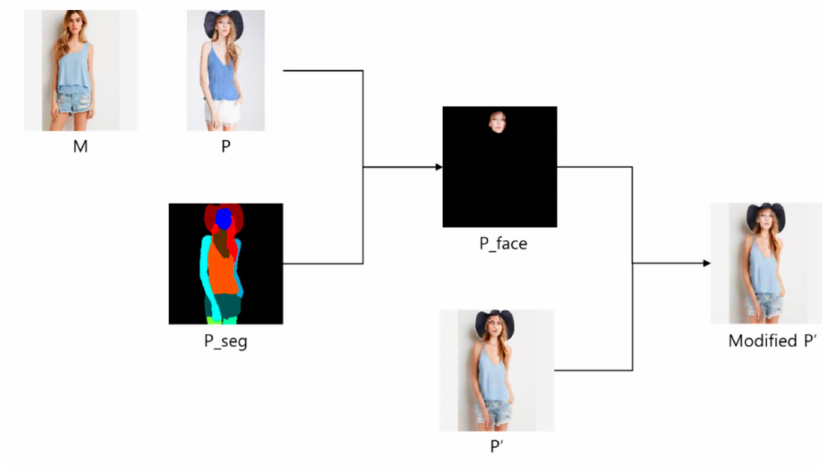
Figure 9. Correction process of the generated